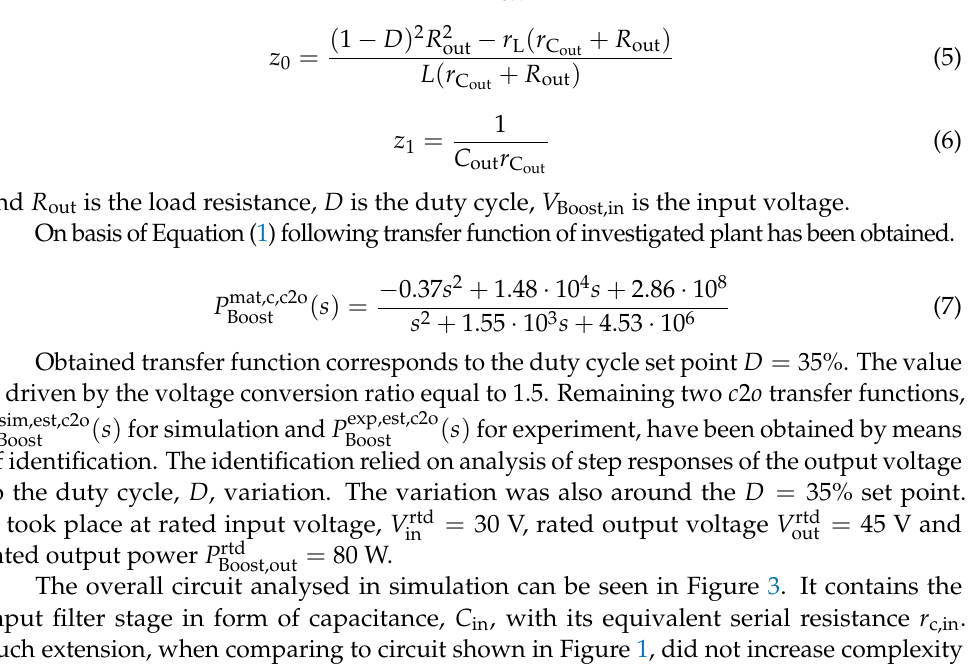
( s ) . The circuit corresponds Boost